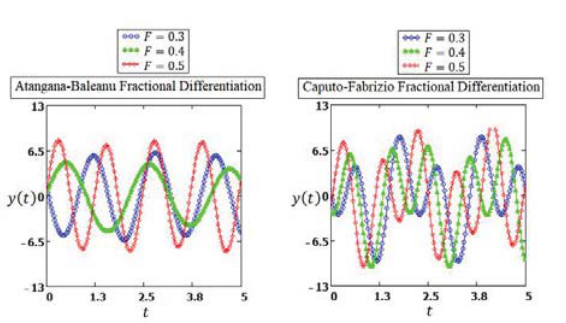
Figure 3: Profile of displacement for excitation amplitude response curves with parametric values ω = 1.2, τ 0 = 0.2, η 1 = η 2 = 0.7 subject to Atangana-Baleanu and Caputo-Fabrizio fractional differential